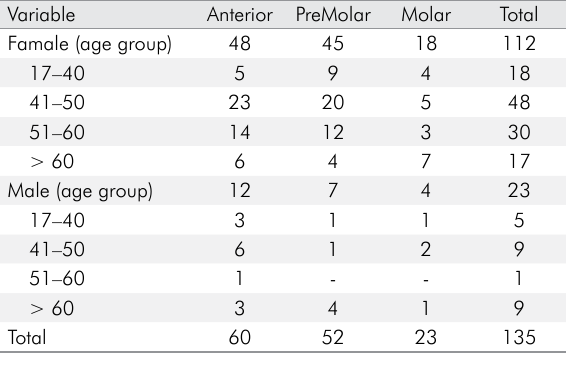
Table 1. Distribution of restoration evaluated according to patient gender, patient age group, and region.